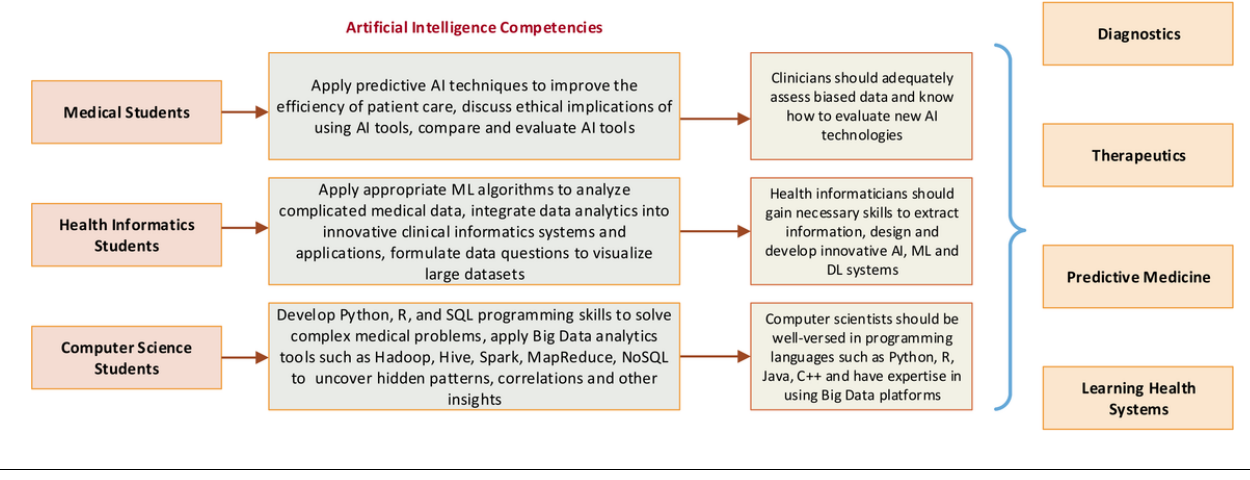
Figure 5. Proposed framework for specialized AI training for different professional fields. AI: artificial intelligence; DL: deep learning; ML: machine